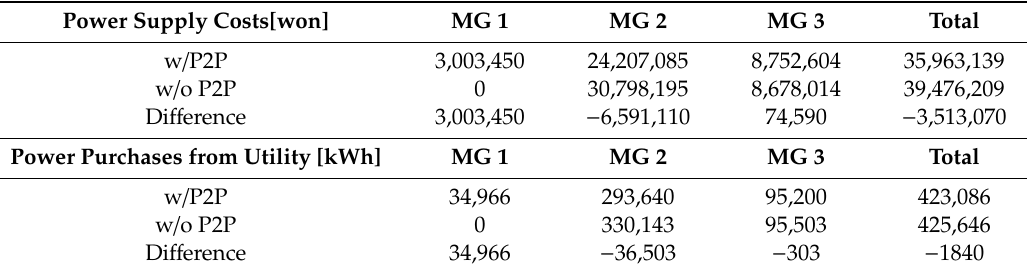
Table2. Comparisonsoftotalpowersupplycostsandtotalpowerpurchasesfromutilityineachscenario.